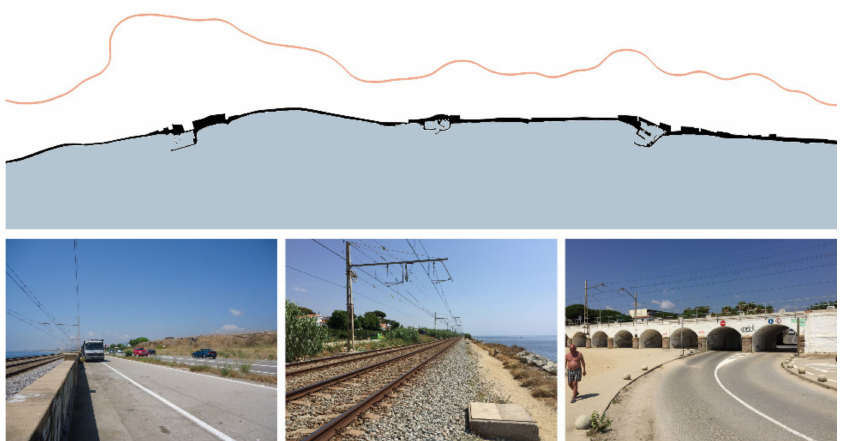
Figure 5. Longitudinal continuity studies the effects of the infrastructures and the civic ways which connect different urban settlements all along the coast (Source: authors’